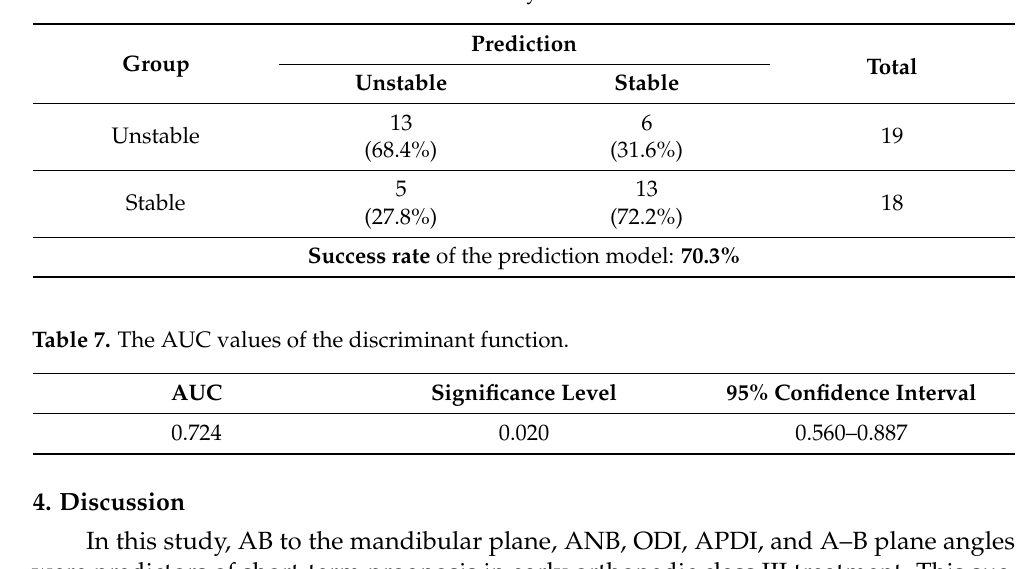
Table 6. Classification results of discriminant analysis.